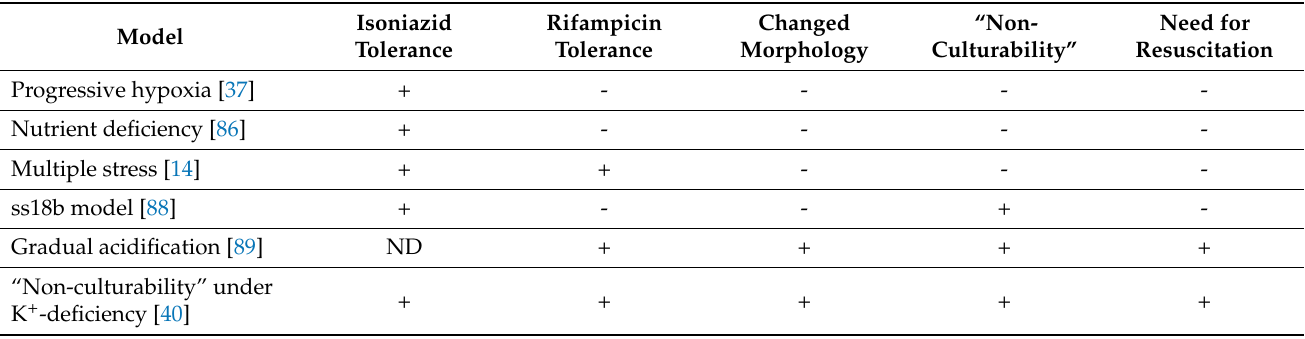
Table 1. The spectrum of TB dormancy models in vitro